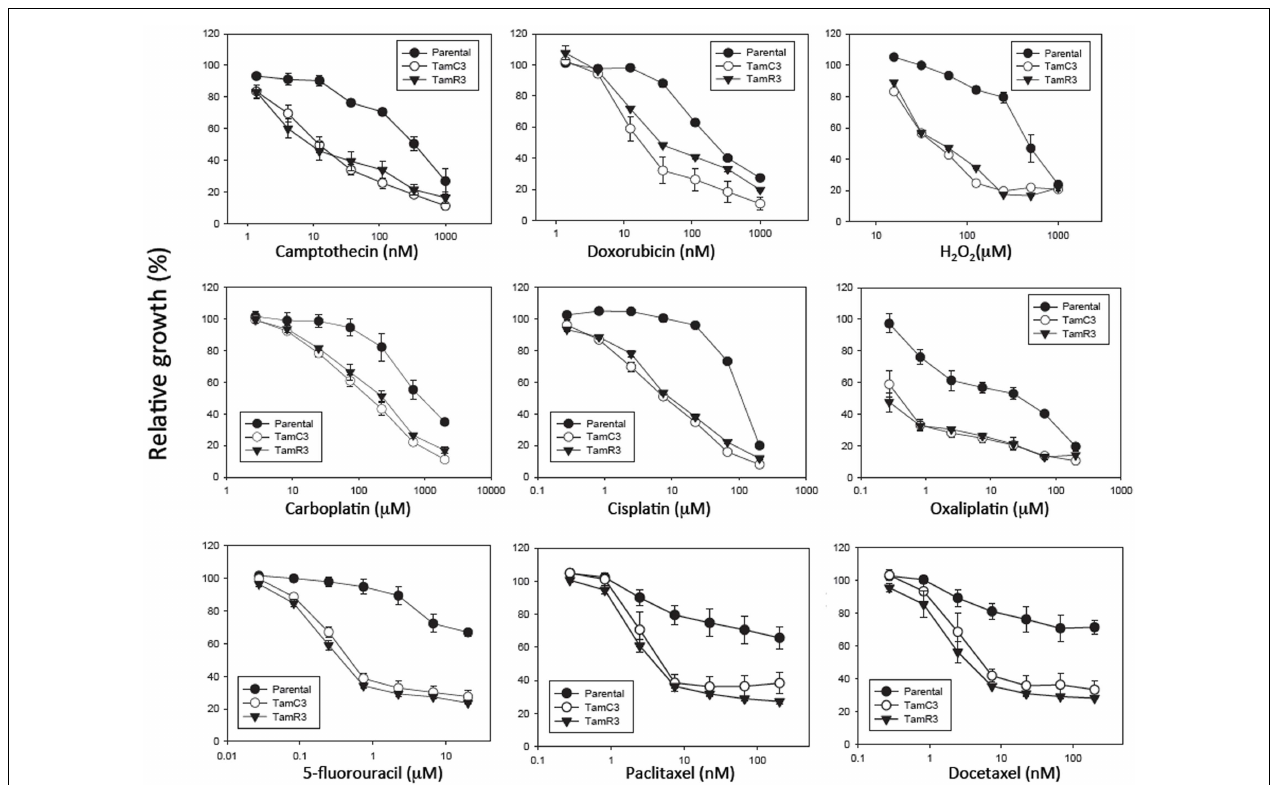
FIGURE 3 | Growth inhibitory effect of drugs on MCF-7 and its sub-lines . Cells were treated with drugs for 3days and cell proliferation was measured by the sulforhodamine B assay. Bars indicate SE in two independent experiments. *Significantly different from MCF-7 parental line ( p < 0.05).